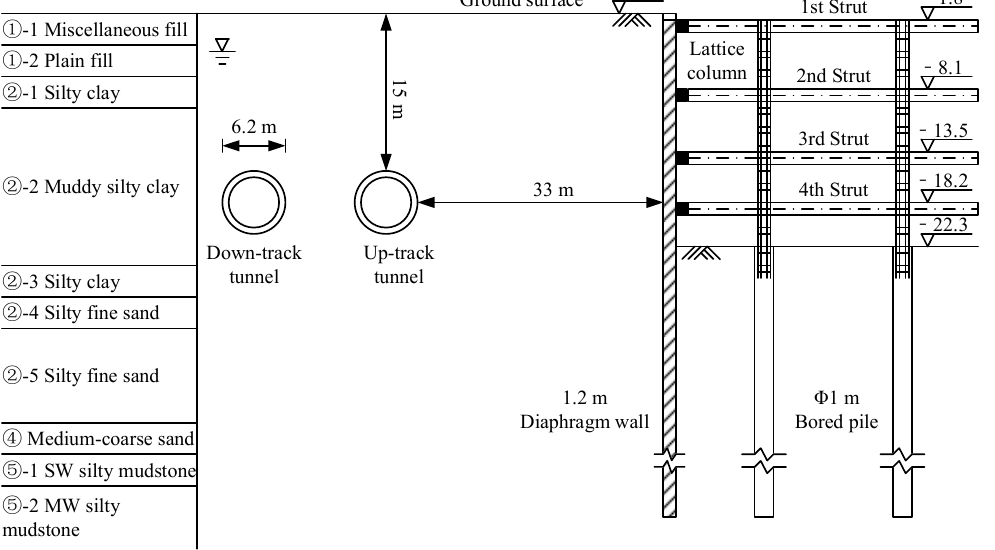
Figure 15. Cross section of the basement excavation and existing tunnels.